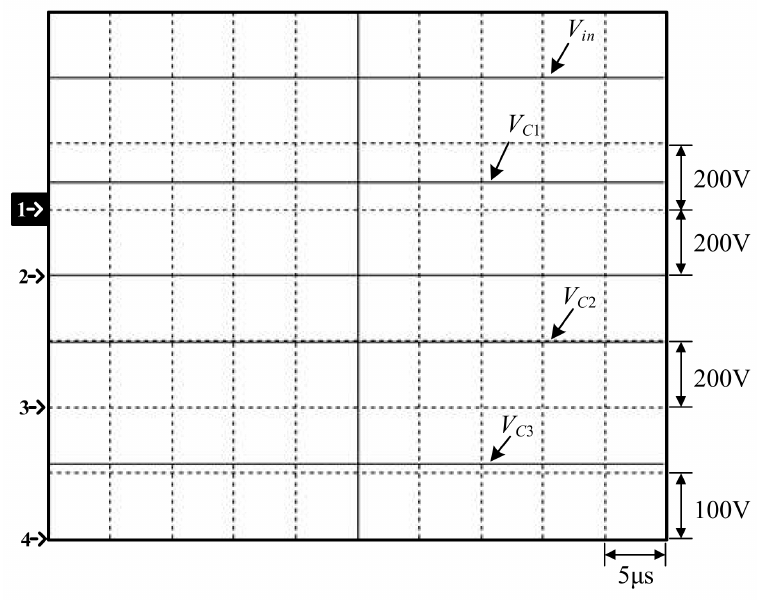
Figure 30. Simulated waveforms relevant to different numbers of LEDs for LED strings: (1) V in ; (2) V C 1 ; (3) V C 2 ; (4) V C 3